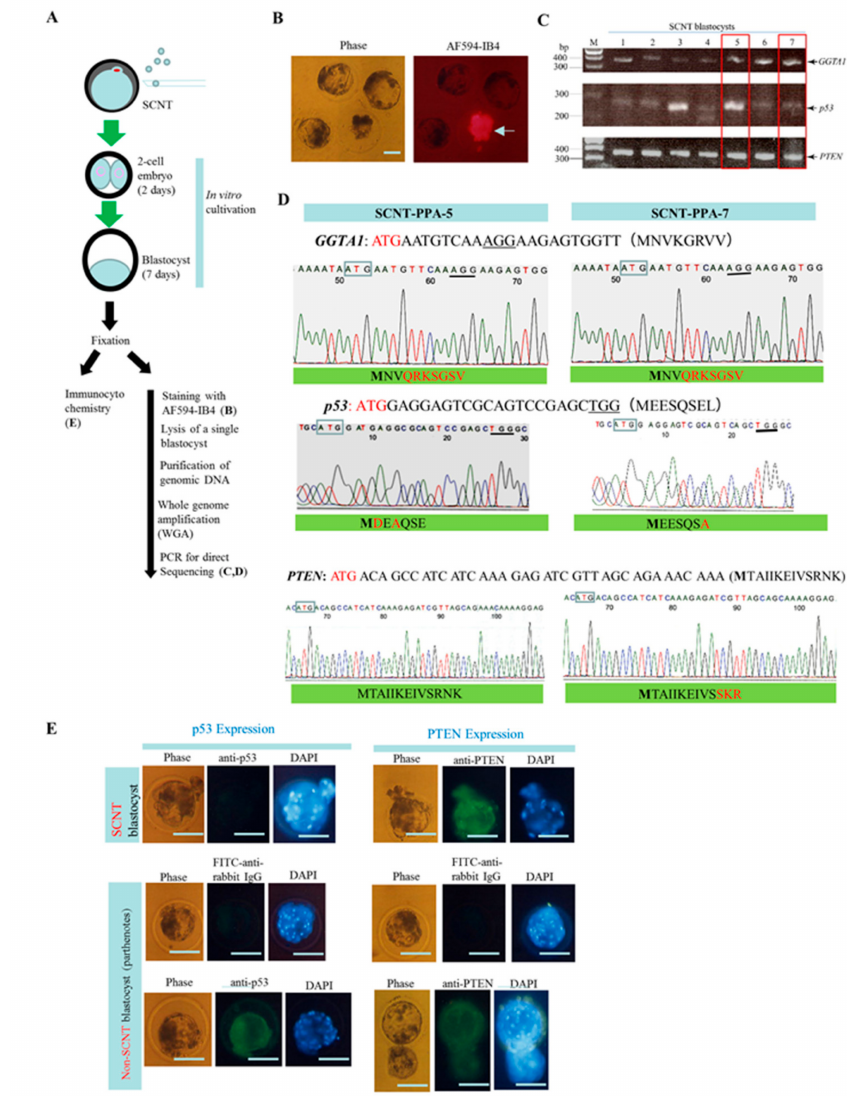
Figure 4. ( A ) Flowchart of somatic cell nuclear transfer (SCNT) experiment using PPA-1 as an SCNT donor. On days 2 and 7 after SCNT, developmental rates of SCNT embryos to two-cell and blastocyst were checked. The blastocysts developed were subjected to AF594-IB4 staining or immunostaining with antibodies. The AF594-IB4-stained blastocysts were used for genomic DNA isolation for molecular biological analyses; ( B ) staining of SCNT blastocysts with AF594-IB4. Phase, photographs taken under light microscopy; AF594-IB4, photographs taken under UV illumination to detect AF594-IB4--derived red fluorescence. Bar = 30 µ m; ( C ) electrophoretic pattern of PCR products (SCNT-PPA-1 to 7) derived from a single SCNT blastocyst using primer sets specific to each gene ( GGTA1, p53 , and PTEN ). The PCR products enclosed by red box were subjected to direct sequencing. M, 100 bp-ladder markers; ( D ) direct sequencing of PCR products from SCNT-PPA-5 (left panel) and SCNT-PPA-7 (right panel) using primers specific to PTEN , p53 , or GGTA1 gene. The start codon ATG is shown by boxes or in red. PAM is indicated by underlines. Below the ideograms, deduced amino acid sequence is shown. The amino acid sequence shown by red was different from that of the authentic protein; ( E ) immunocytochemistry of SCNT blastocysts using anti-PTEN and anti-p53 antibodies. Parthenogenetically developed blastocysts (shown as non-SCNT blastocyst) were used as positive control. The non-SCNT blastocyst reactive with only second antibody (fluorescein-labeled anti-rabbit IgG) were designated as negative control. All embryos were counterstained with DAPI upon reaction with the second antibody. Bar = 30 µ